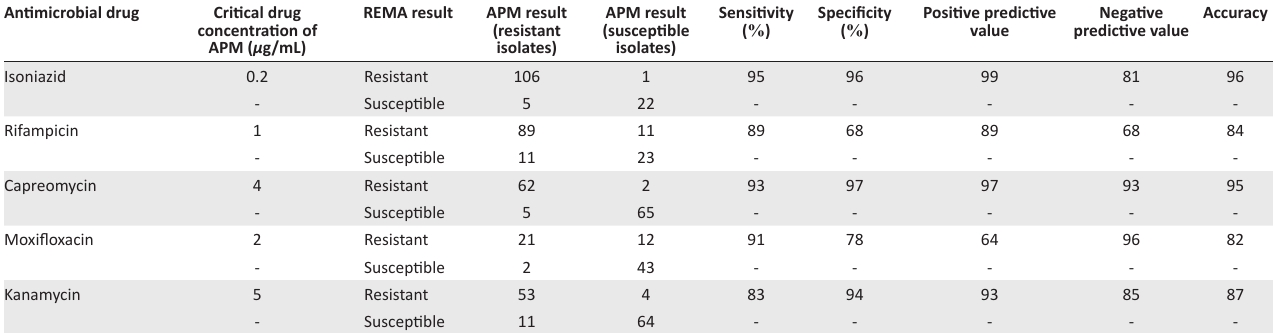
TABLE 2: Comparative performance of the resazurin microtitre plate assay and agar proportion method on multidrug-resistant and extensively drug-resistant tuberculosis isolates, Inkosi Albert Luthuli Central Hospital, Durban, South Africa, January 2014 – June 2015. Antimicrobial